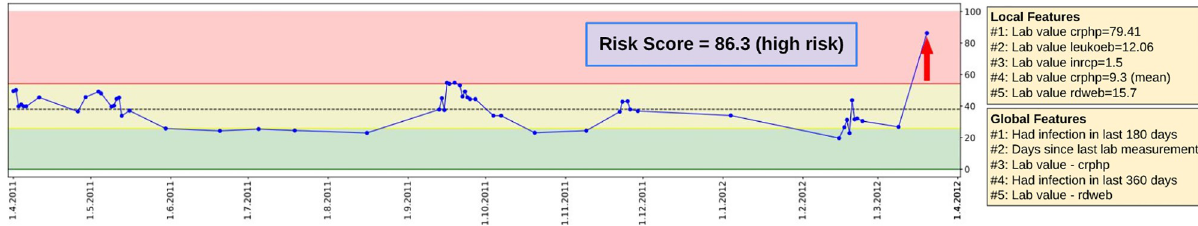
Fig 2. Overview of the dashboard which shows the recent risk score (red arrow), together with the previous risk scores of the patient over time depicted in a graph. Moreover, the dashboard shows the most important local features, which had a direct influence on the current scoring of the model, as well as the most relevant global features, which had generally a strong influence on the